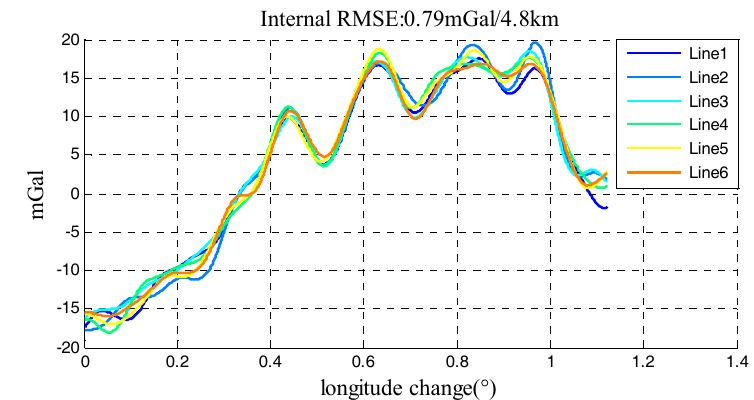
Table 7. The standard deviation of four factors and internal RMSE in Neimeng flight.